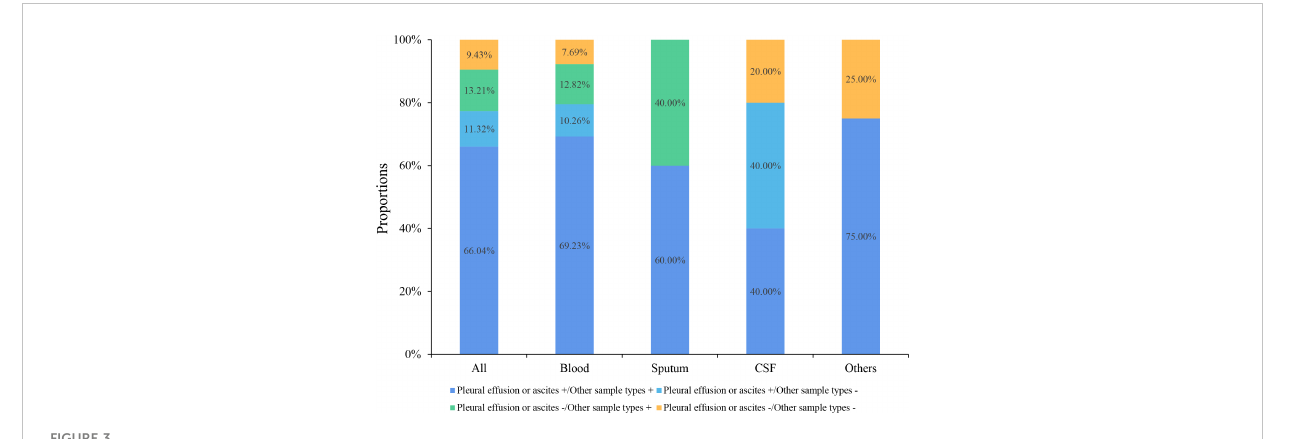
FIGURE 3 Consistency of mNGS test results between pleural effusions or ascites and the other sample